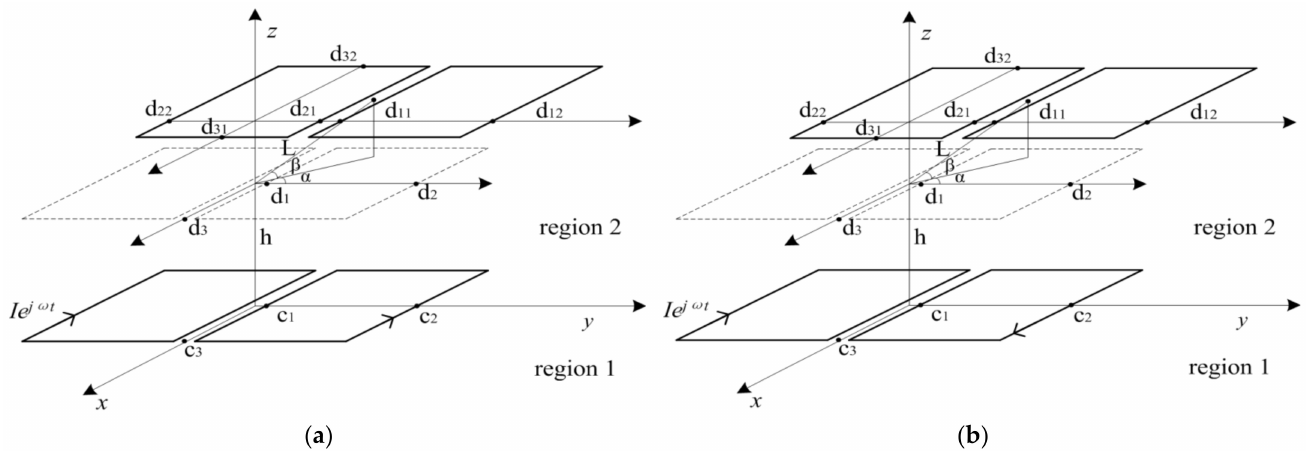
Figure 1. Layout of the dual Double-D(DD–DD) filamentary coupler under misalignment. ( a ) Driven by the opposite phase currents; ( b )Driven by the in-phase